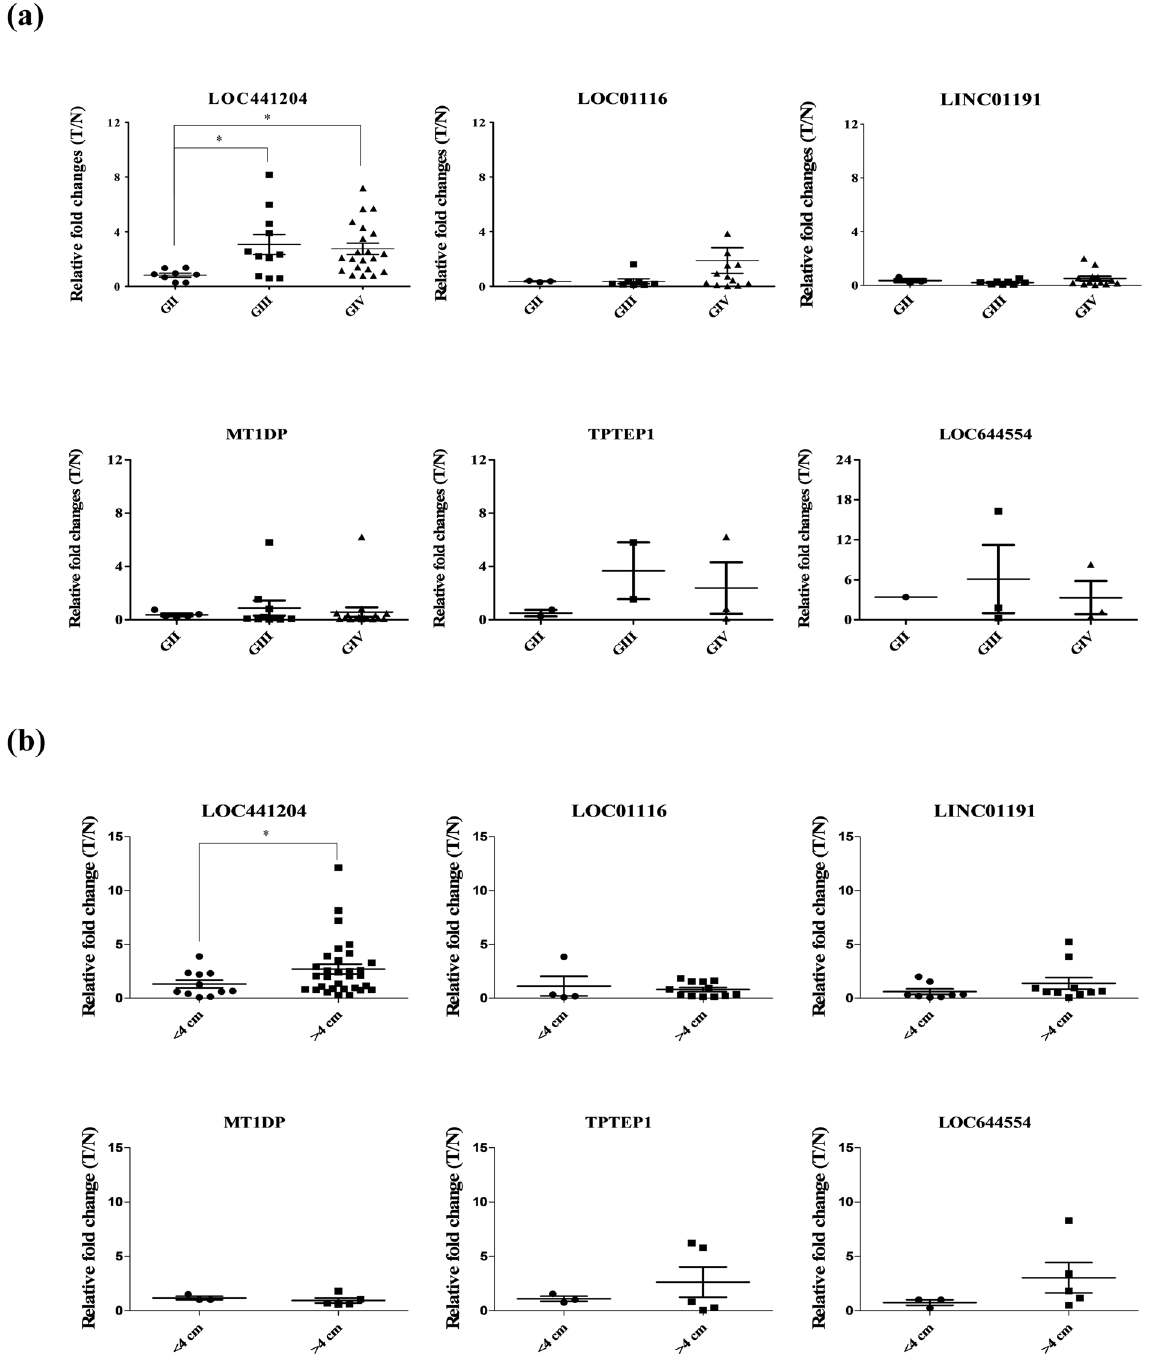
Figure 2. Clinical correlations of lncRNAs with associated parameters in brain tumor. Q-RT-PCR analysis of dys-regulated lncRNAs expression in 40 paired brain tumor specimens. ( a ) Tumor grade, ( b ) Tumor size. T/N ratios of lncRNAs. Differences were analyzed using one-way ANOVA, * P <